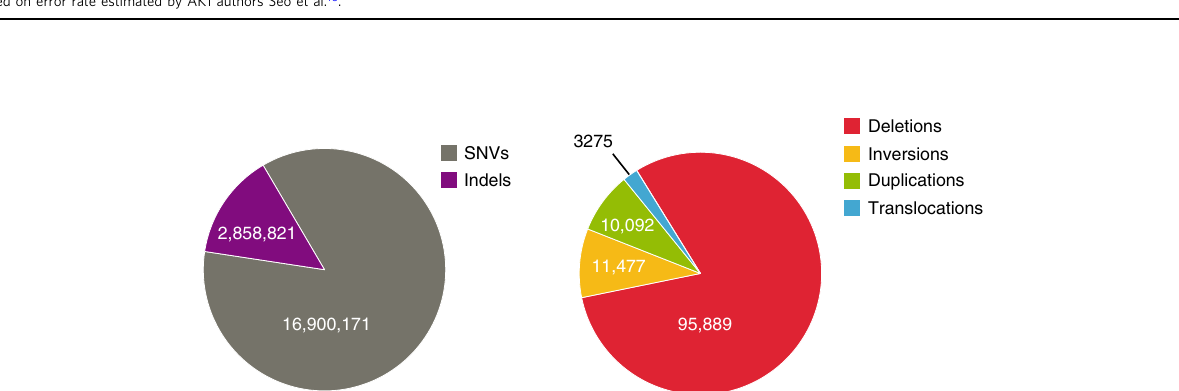
The table lists the fi nal EGYPT meta assembly, the two alternative base assemblies EGYPT_wtdbg2 and EGYPT_falcon and two publicly available assemblies of the genomes of a Korean (AK1) and Yoruba individual (YORUBA). Metrics were largely obtained with QUAST-LG. The complete QUAST-LG report and additional assembly metrics are provided in Supplementary Data 2. a Based on error rate estimated by AK1 authors Seo et al. 16 .